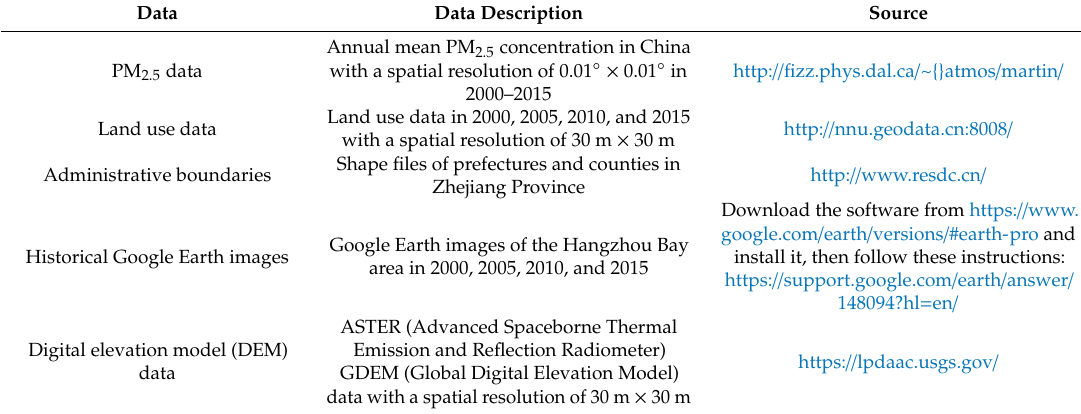
Table 1. Description of the data used in this